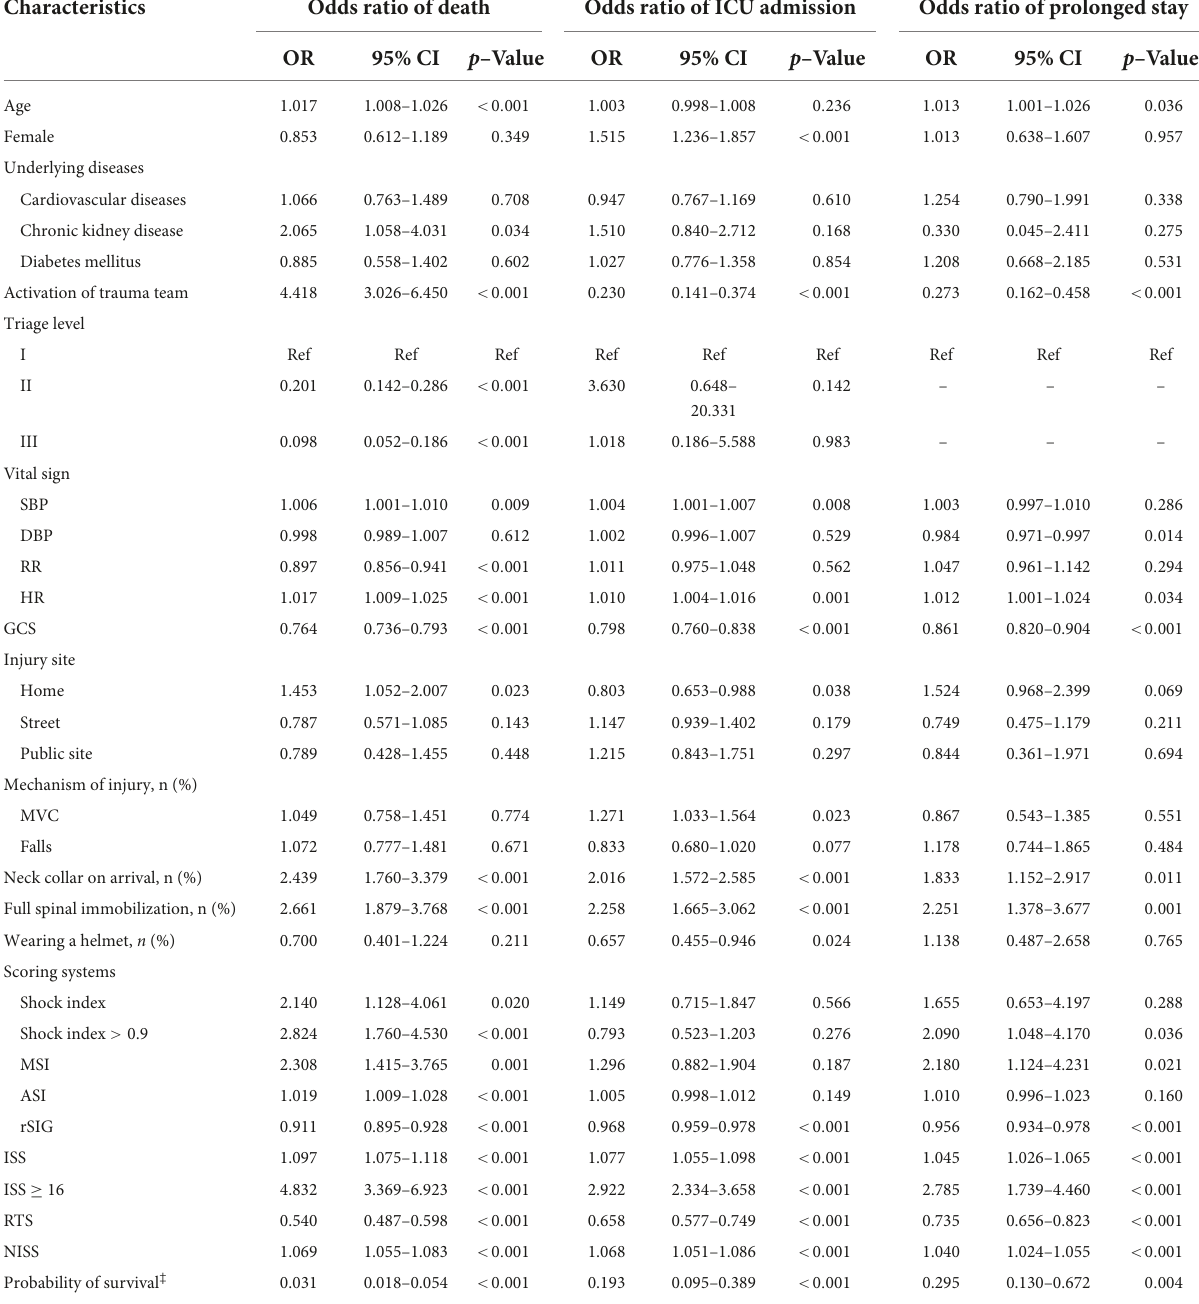
TABLE 2 Clinical outcome prediction by univariable logistic